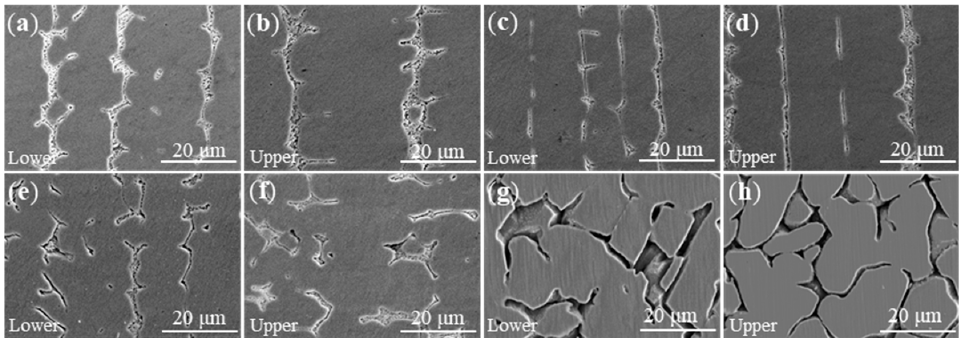
Figure 5. Effect of deposited height on microstructure in different treatment (X-Z plane): ( a , b ) sample C2, ( c , d ) sample C3, ( e , f ) sample U2, ( g , h ) sample U3.